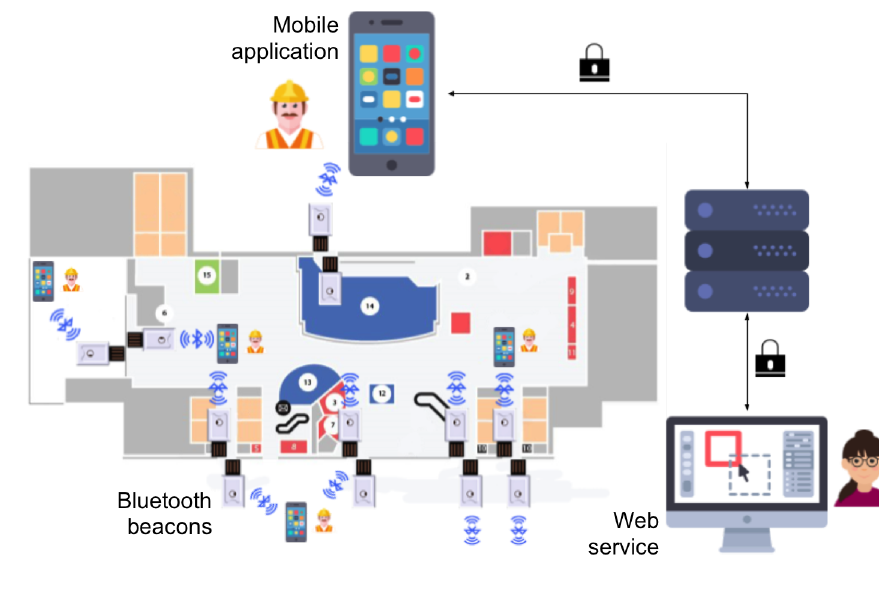
Figure 1. Proposed